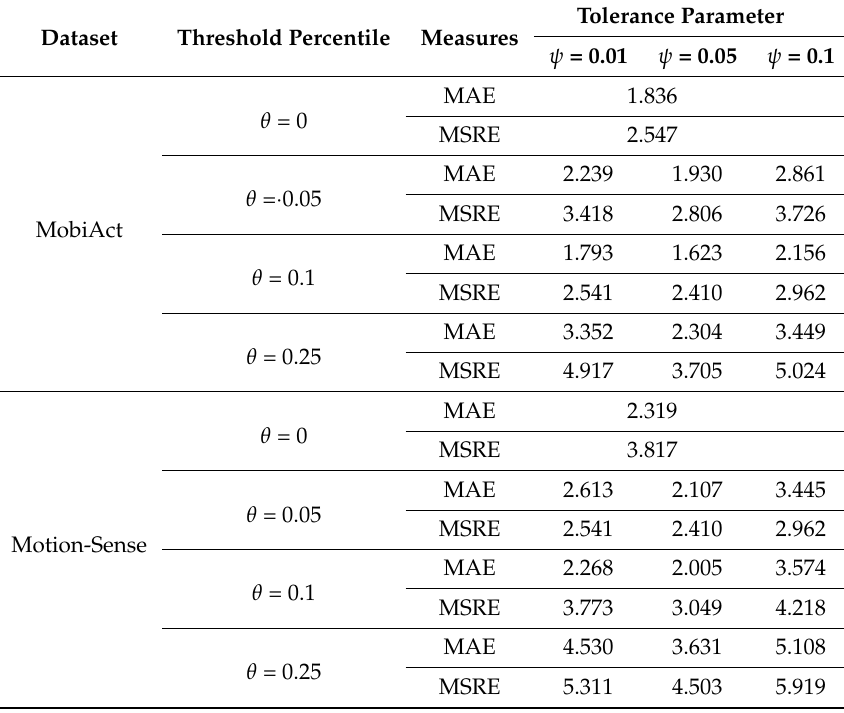
Table 5. The experimental results in the jogging state with data filtering.